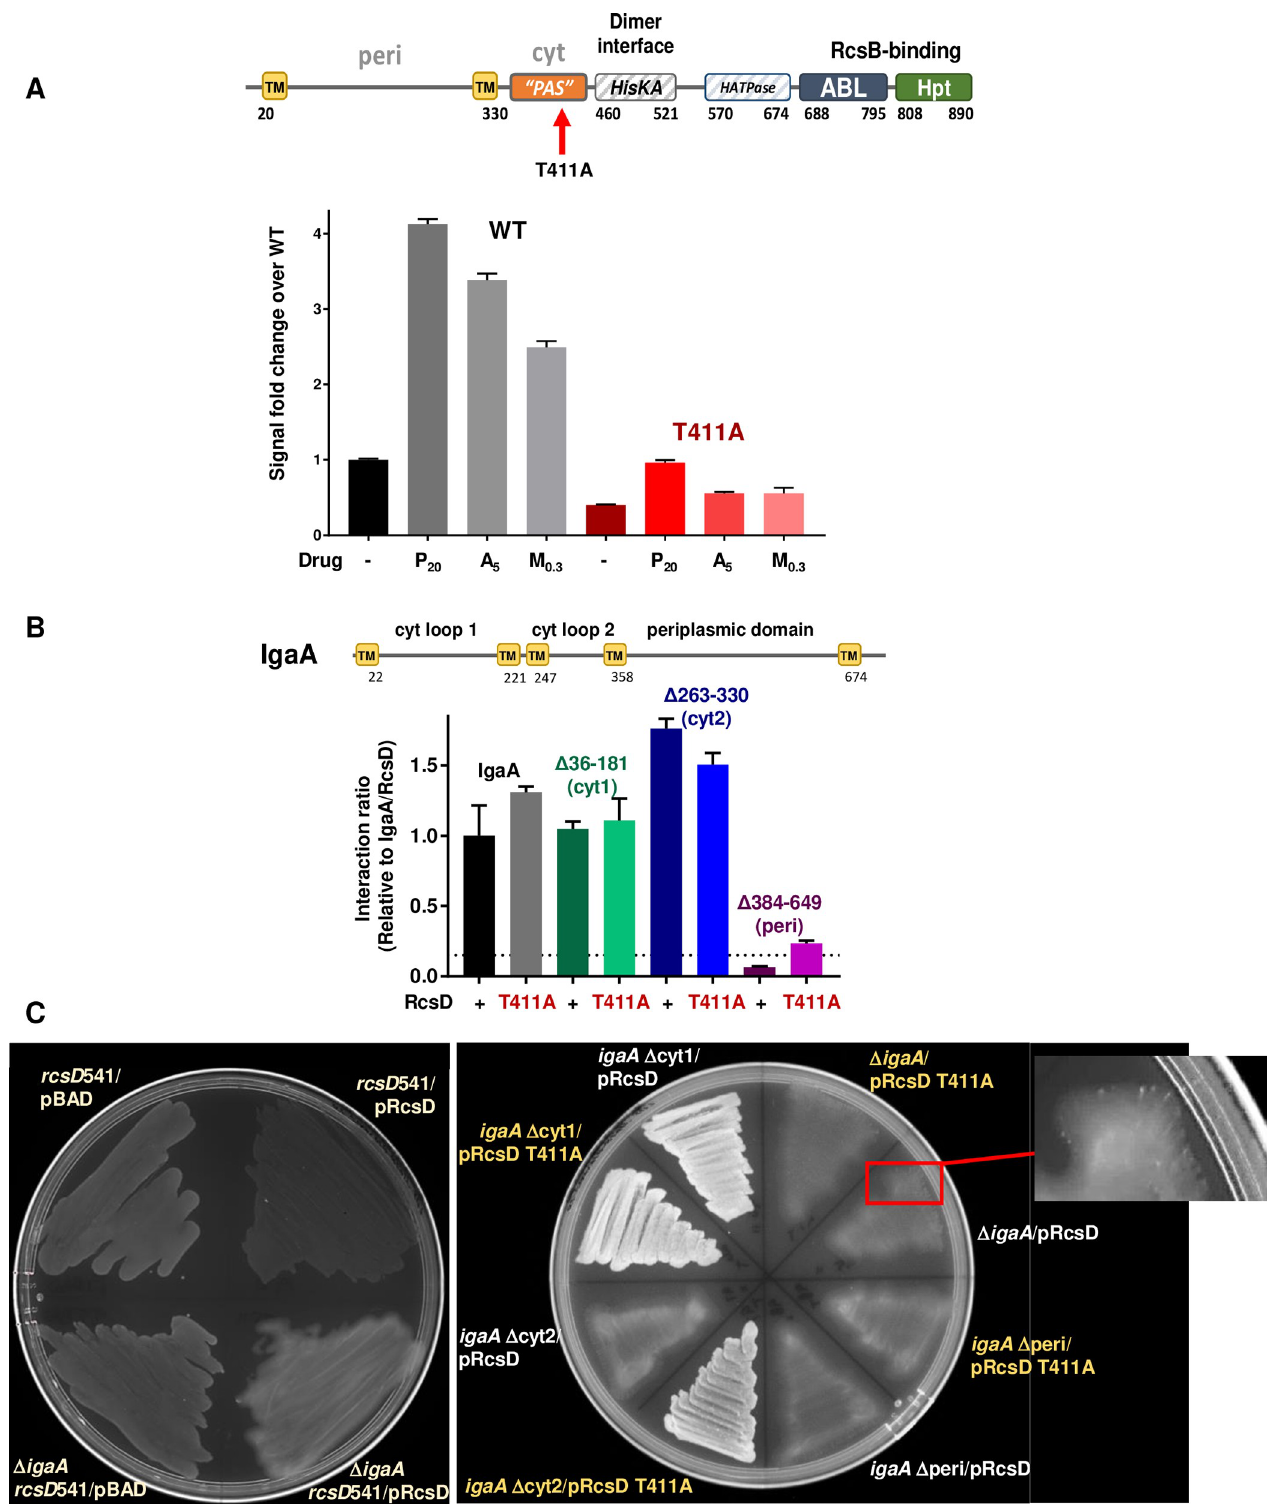
Fig 4. An RcsD mutation that blocks Rcs induction by increasing IgaA interaction. A. RcsDT411A does not respond to Rcs stimuli. Schematic shows domains of RcsD and position of T411A, within the PAS-like domain. Both wild type and rcsD T411A strains (EAW8 and EAW121) were treated with nothing (-), 20 μ g/ml polymyxin B nonapeptide (P 20 ), 5 μ g/ml MreB inhibitor A22 (A 5 ) or 0.3 μ g/ml Mecillinam (M 0.3 ). Both A22 and Mecillinam give a